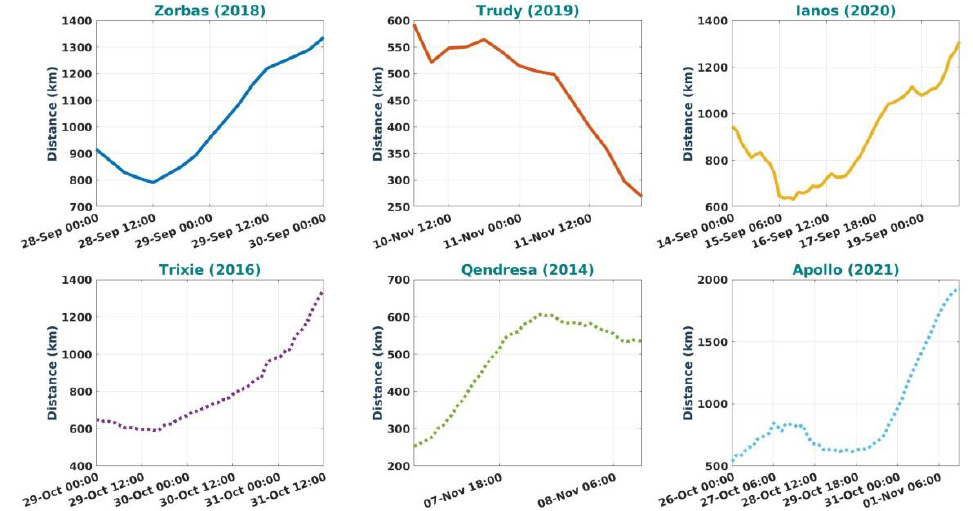
Figure 2. Distance of the medicane’s eye to the station IS48. The same color and line code is applied as in Figure 1.